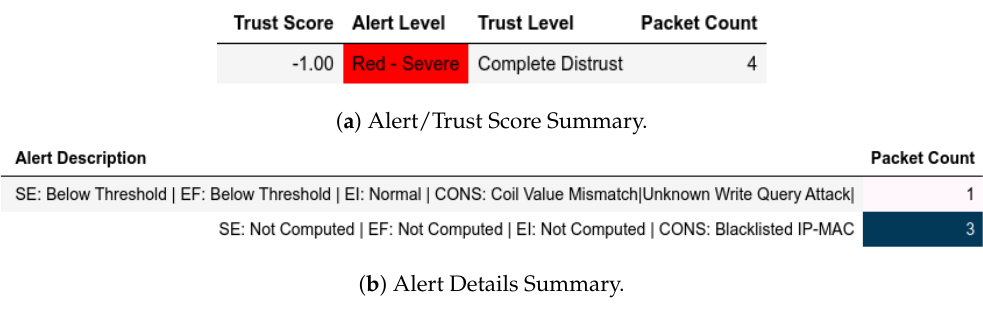
Figure 16. Server: EPM dataset internal test with IP-MAC blacklisting- H (cid:48) in send-fake-command attack